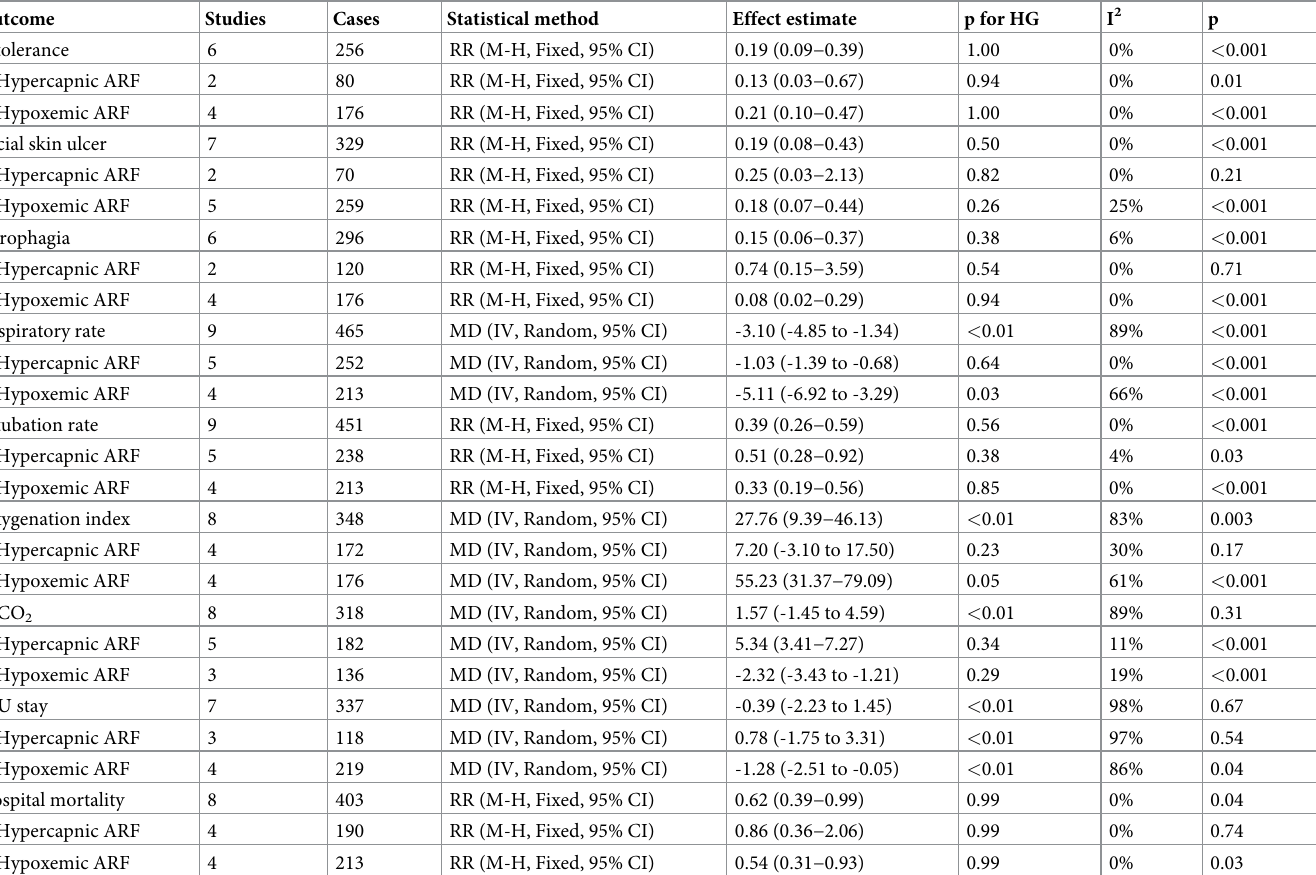
Table 2. Meta-analyses for comparing helmet versus face mask.